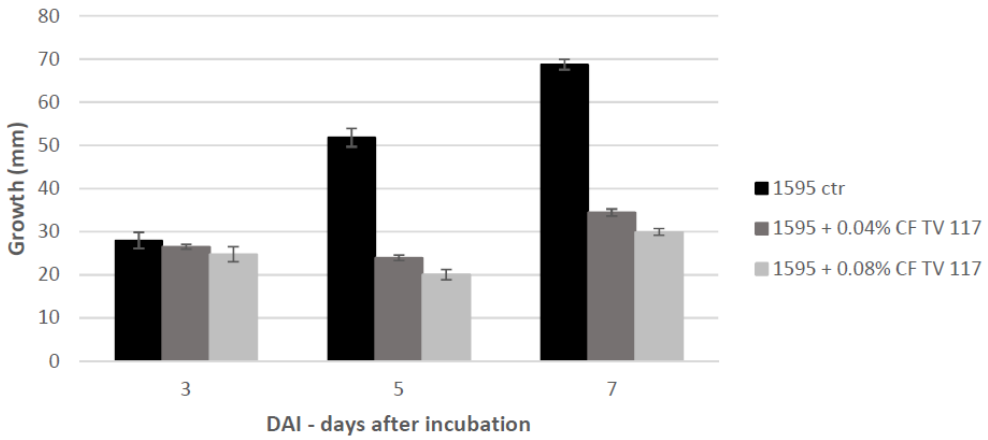
Figure 1. Growth inhibition of F. langsethiae (1595) treated with 0.04 and 0.08% w / v of CF TV117. Histograms of the growth during the time (3, 5 and 7 dai) and the percentage of the growth inhibition in comparison with the control (ctr) (100%) is reported. The data are the mean ± SD of 3 experiments.